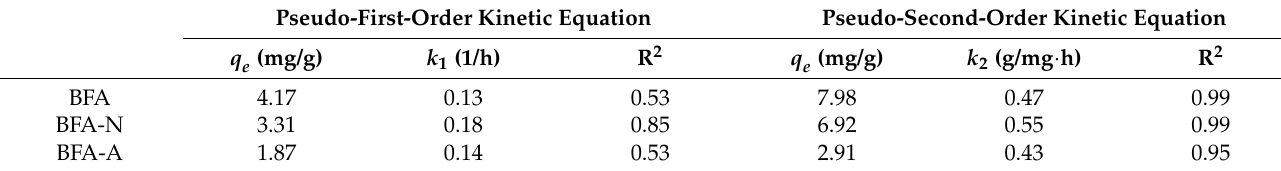
Figure 7. Absorption kinetic fitting of Cd by BFA, BFA-N, and BFA-A, ( a ) pseudo-first-order kinetic model, ( b ) pseudo-second-order kinetic model. model, ( b ) pseudo-second-order kinetic model. Table 2. Absorption kinetic fitting parameters of Cd by BFA, BFA-N, and